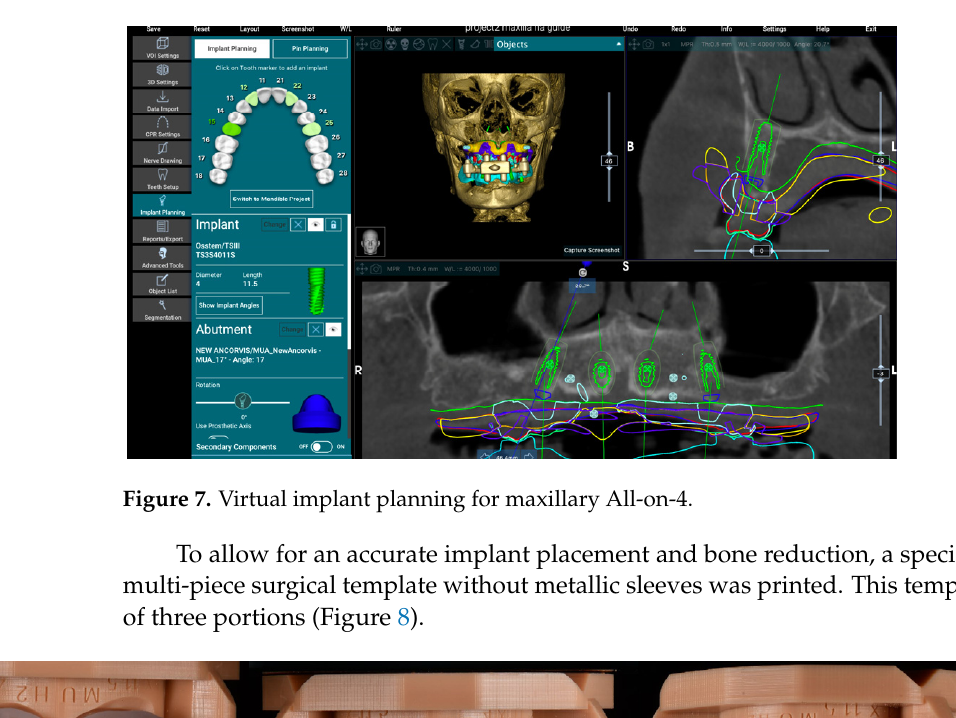
Figure 6. Placed implants with OT Equators (Rhein’83, Bologna, Italy).